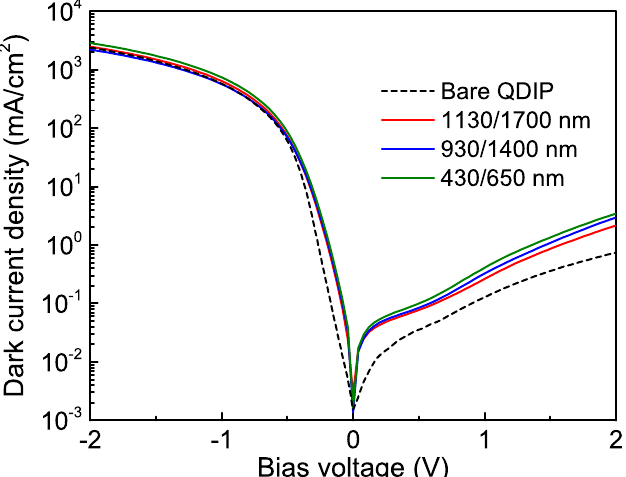
Figure 3. The biasdependence of the dark current density in the Ge/Si QDIPs with and without photon-trapping hole arrays. The hole diameter/period values are 430/650 nm, 930/1400 nm, and 1130/1700